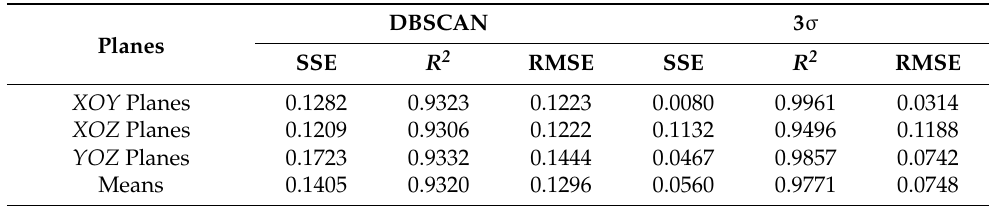
Table 5. Evaluation of threshold setting results.